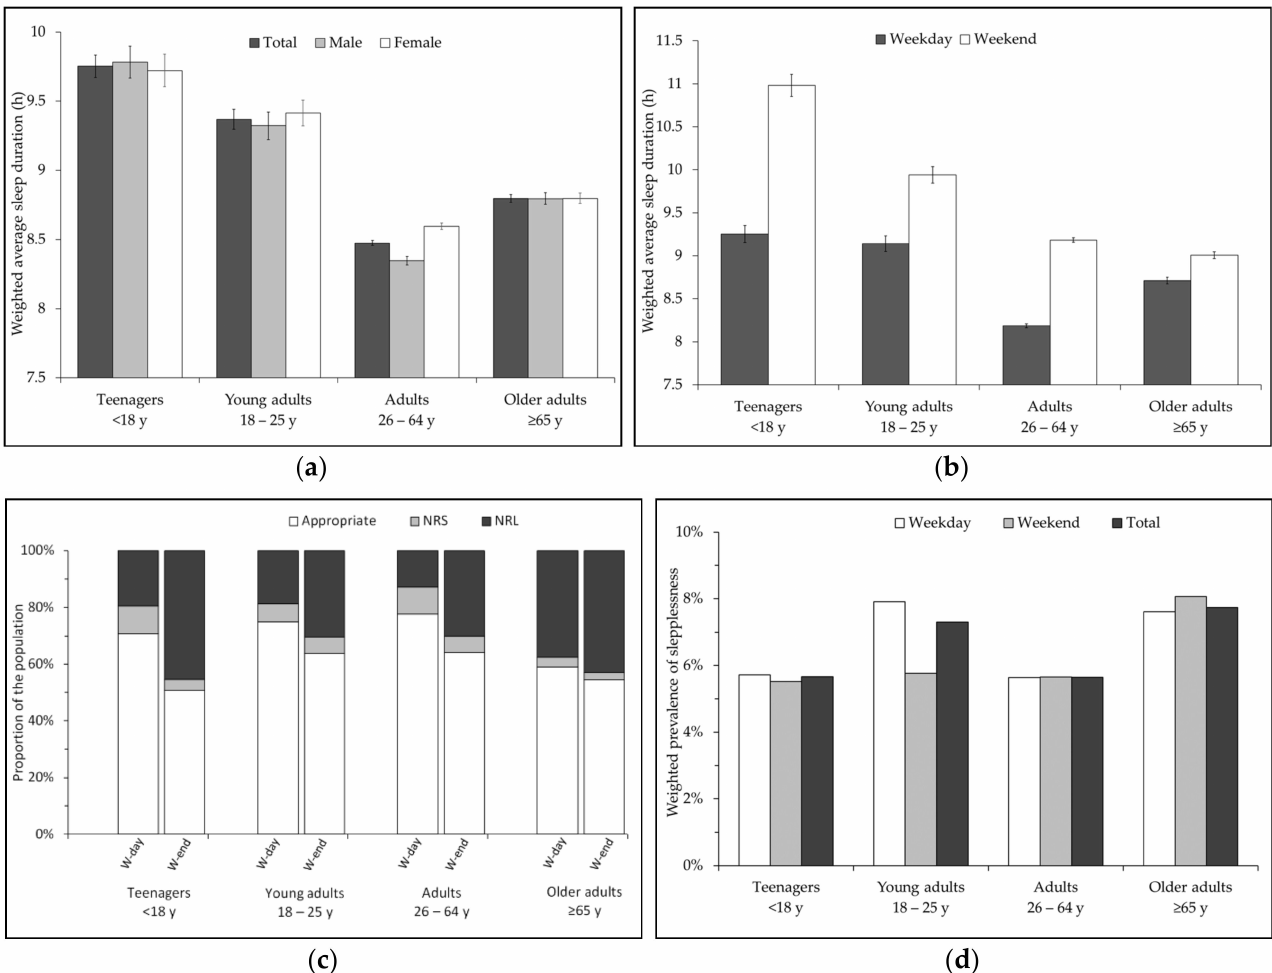
Figure 1. Sleep characteristics of ATUS respondents: ( a ) Average sleep duration by sex and age categories. Teenagers’ age category includes 15- to 17-year-olds; ( b ) average weekday and weekend sleep duration by age categories; ( c ) distribution of the population by three sleep duration alignment categories (appropriate, ARNRS—not recommended: too short; NRL—not recommended: too long) on weekdays (w-day) and at weekends (w-ends); ( d ) proportion of sleeplessness on weekdays and at weekends by age